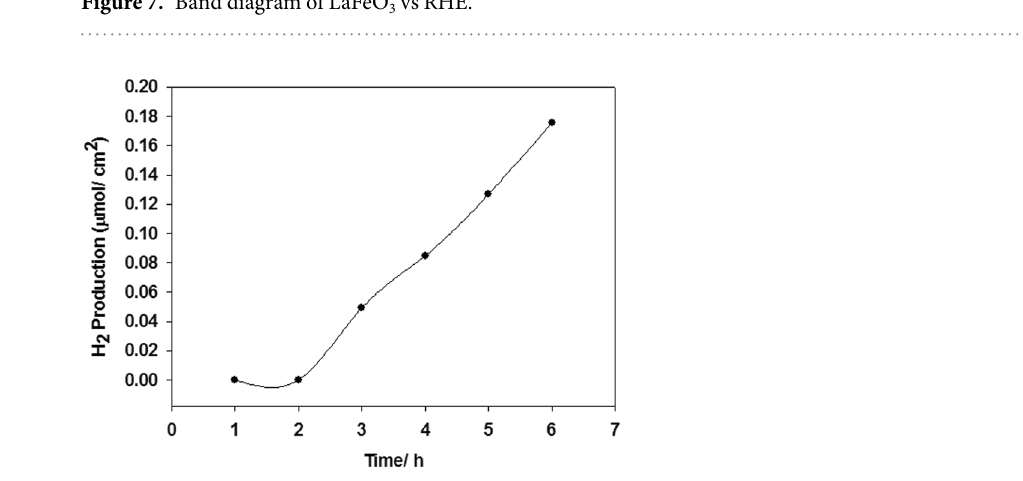
Figure 7. Band diagram of LaFeO 3 vs RHE.